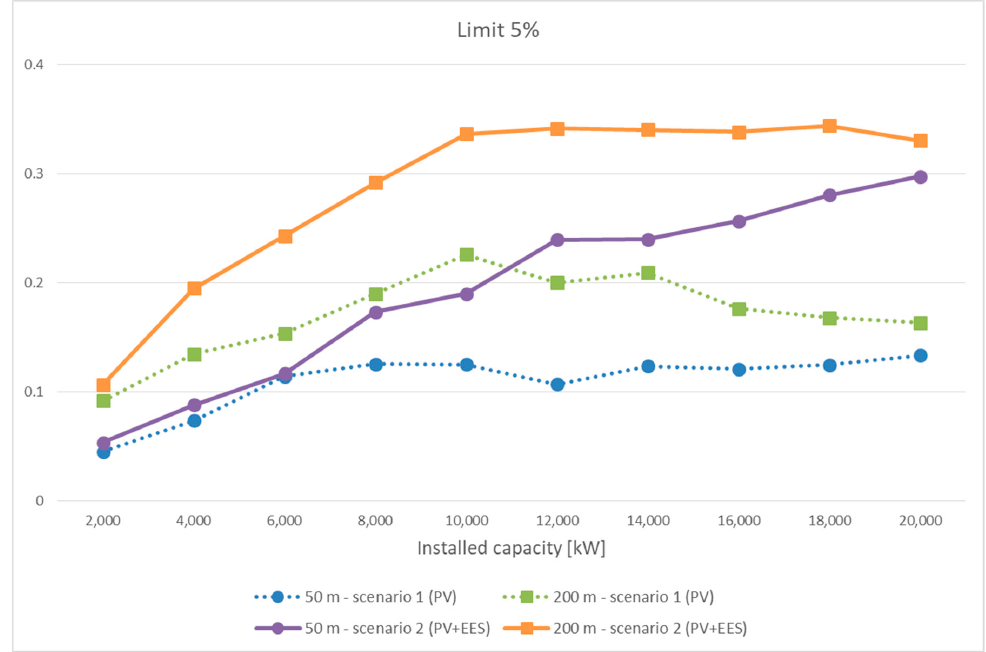
Figure 10. Combined effect of the 𝑒𝑥𝑐𝑒𝑠𝑠 and 𝑐𝑒𝑛𝑡𝑟𝑎𝑙 𝑠𝑢𝑝𝑝𝑙𝑦 for limit = 5% under the two scenarios